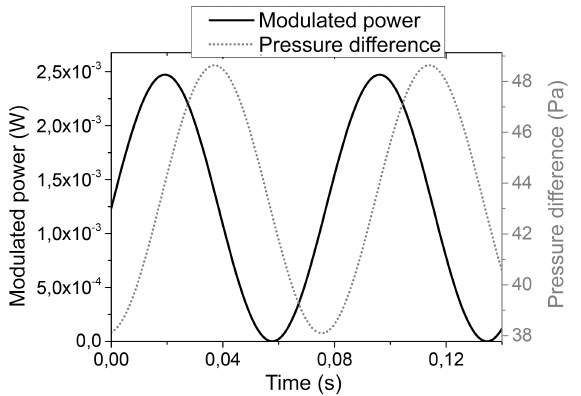
Figure 4. Phase shift between the modulation signal and the result- ing pressure wave in the detection chamber.